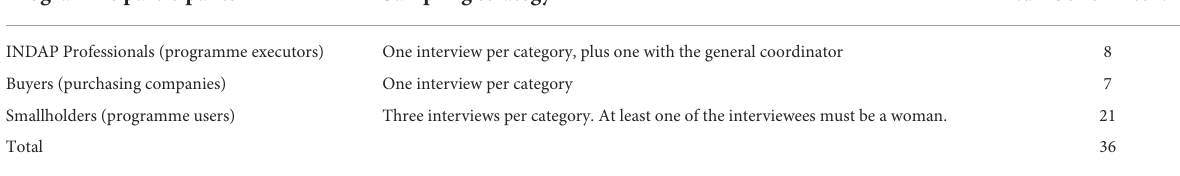
TABLE 3 Sampling criteria for